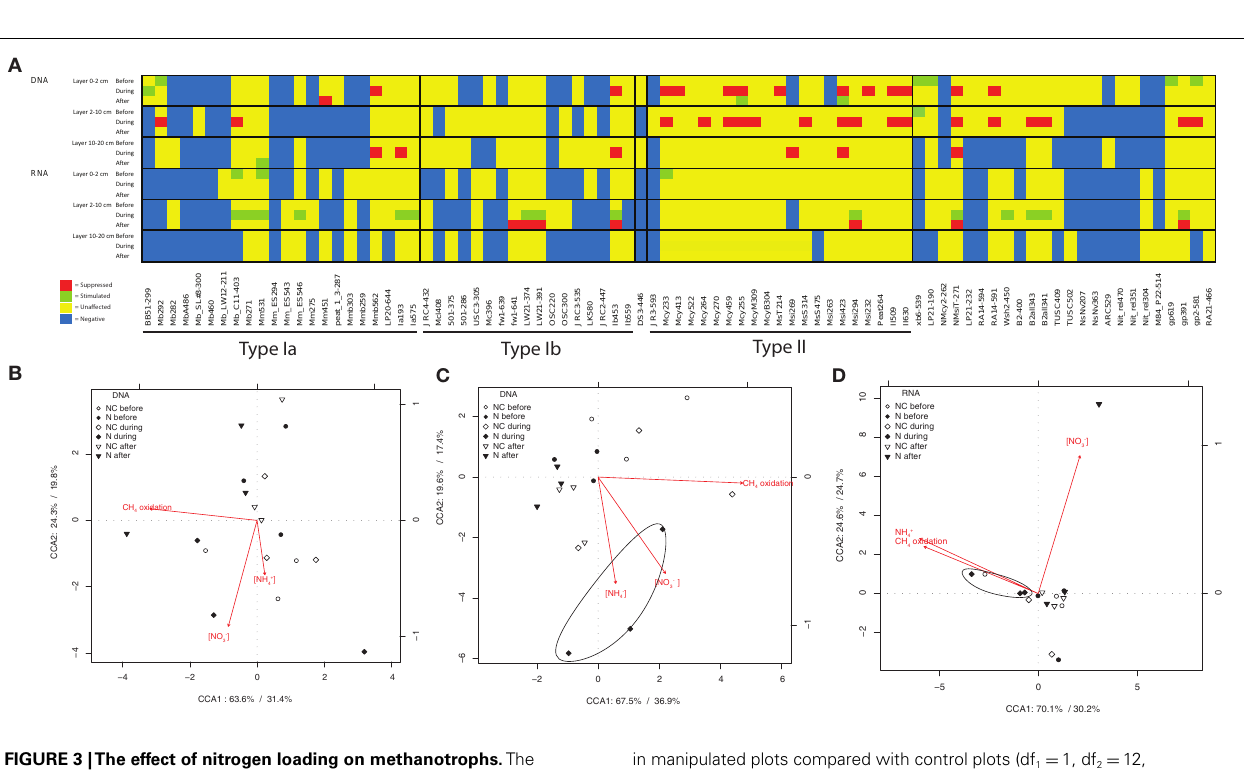
FIGURE 3 |The effect of nitrogen loading on methanotrophs. The species level effects of nitrogen loading on relative abundance of pmoA genes (DNA) and relative abundance of pmoA transcripts (RNA) of methanotrophs. (A) The table summarizes the mixed-effect model tests between manipulated and control plots. Soil samples were taken from control and manipulated plots before, during and after the nitrogen loading for methanotroph community analysis, and the effects of manipulation were evaluated with mixed-effect models. Only probes with signals are shown. TableA2 in Appendix shows complete list of microarray probes used and specificity of them. Effects of nitrogen load on microarray probes